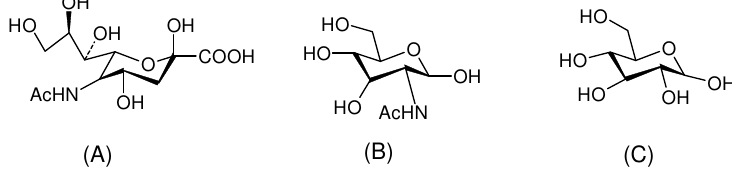
Figure 1 . Structure of compounds used in this study. (A): N -Acetylneuraminic acid (Neu5AC), (B): N -Acetyl-D-mannosamine(ManNAc) and (C):